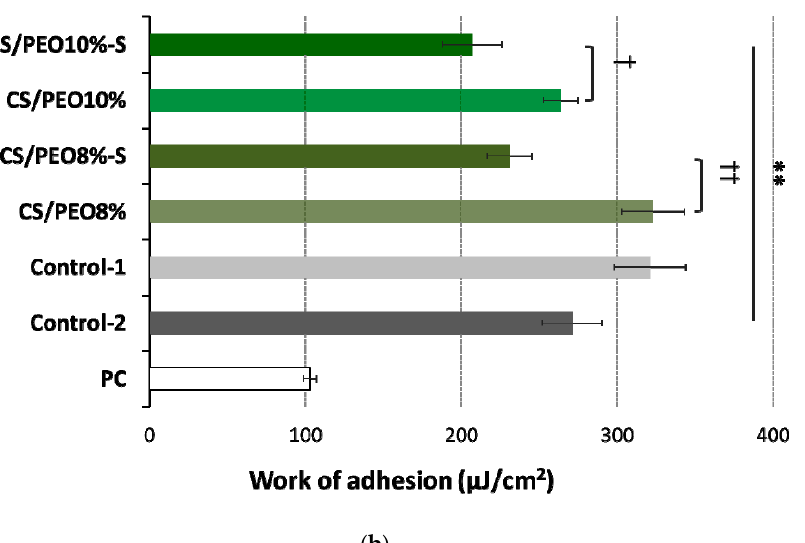
Figure 6. ( a ) Detachment force and ( b ) work of adhesion of CS/PEO nanofibers (prepared from 8% or 10% polymer blend solution) before and after S-coating as compared to cellulose paper (PC) and commercial wound dressings from carboxymethylcellulose sodium (Control-1) or calcium alginate (Control-2) (mean ± S.D.; n = 5); * represents significant differences with p ≤ 0.05, while ** represents significant differences with p ≤ 0.01 in comparison to PC; † and †† symbolize significant differences between uncoated and S-coated nanofibers with p ≤ 0.05 and p ≤ 0.01, respectively.